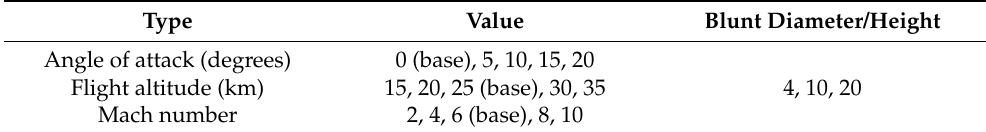
Table 1. Layout of numerical plan.